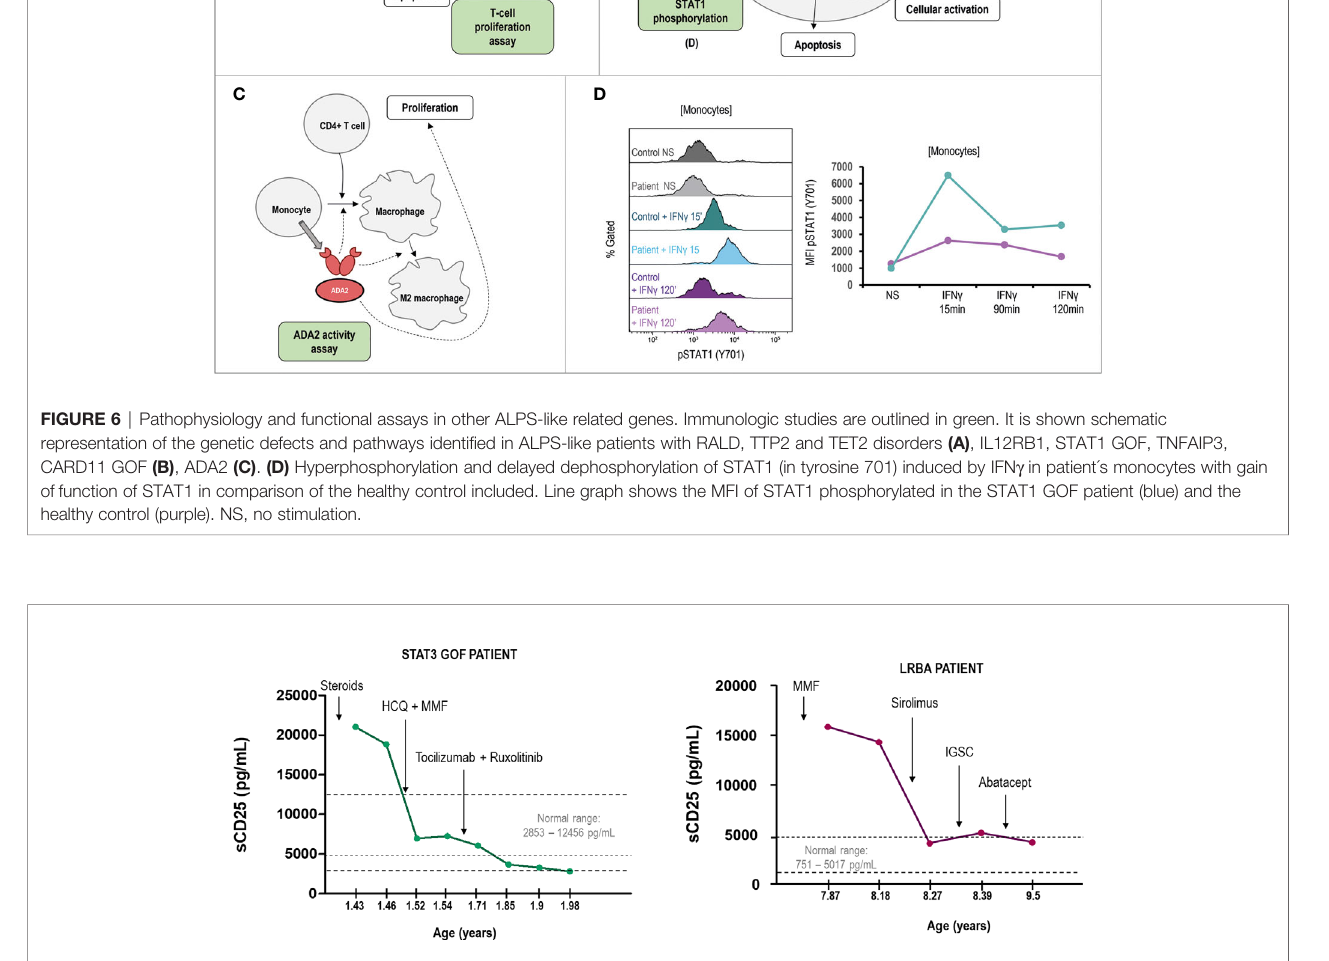
FIGURE 7 | Monitorization of two cases of STAT3 GOF and LRBA de fi ciency measuring sCD25. Arrows indicate the changes in the treatment. HCQ, hydroxychloroquine; MMF, mycophenolate mofetil; SCIg, subcutaneous immunoglobulin